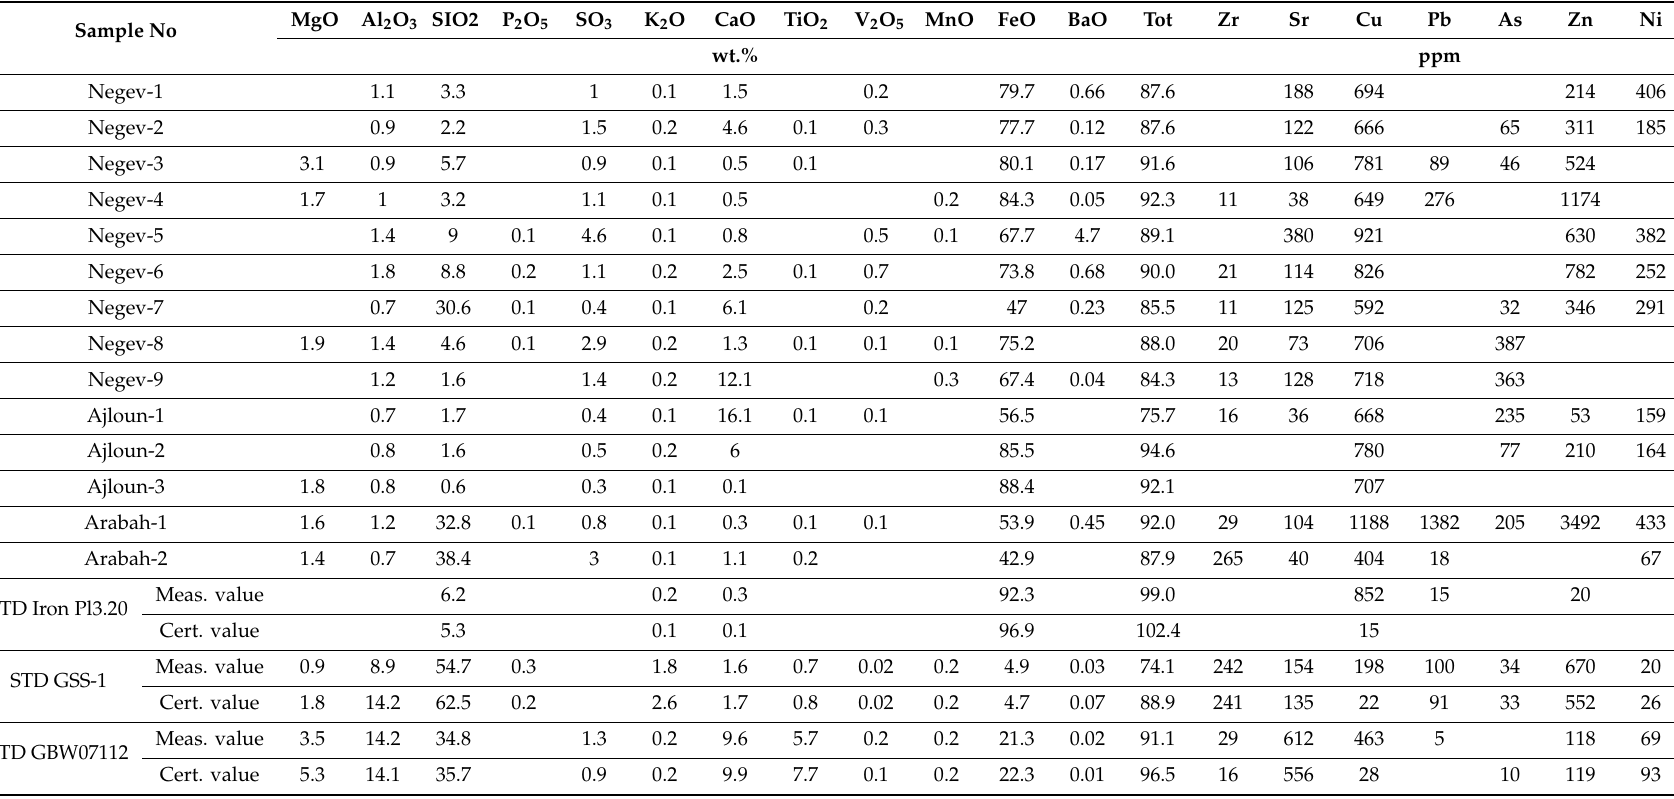
Table 3. Chemical analyses by portable X-Ray fluorescence of 14 ore samples used in the